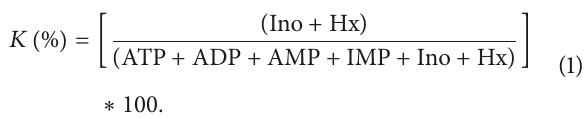
very similar to those reported on the same species after 14-15 and 17-18 days of storage in ice (72.0–78.1% and 84.0–92.5%, resp.) [30,